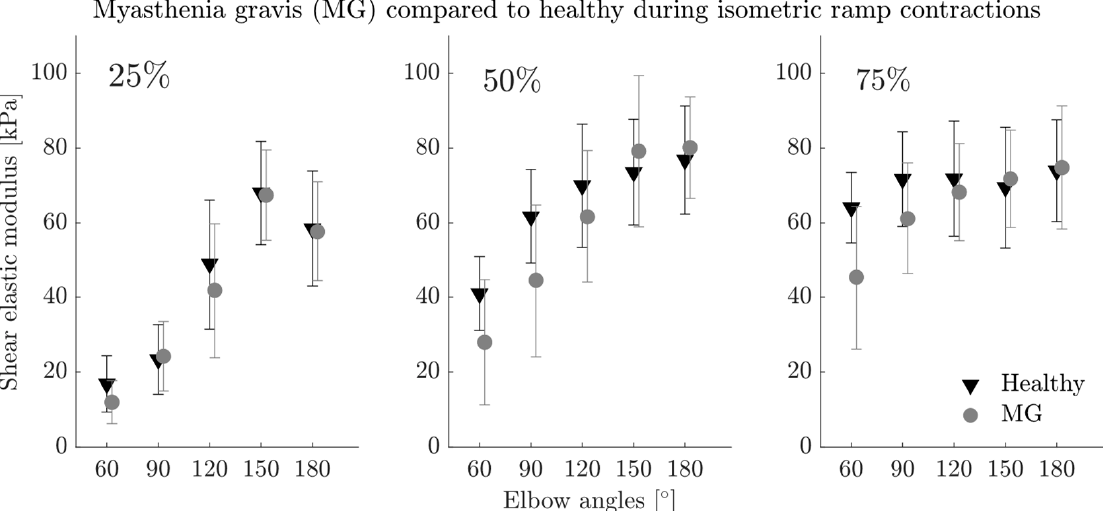
Figure 6. Average total shear elastic modulus of the biceps brachii muscle of myasthenia gravis (MG) patients (grey circles) compared to the healthy group (black triangles) reported previously [13] at 25%, 50% and 75% of maximum voluntary contraction (MVC) torque for the five elbow angles studied (60 ◦ , 90 ◦ , 120 ◦ , 150 ◦ and 180 ◦ ). Error bars visualize the standard deviation. Two-way ANOVA showed significant differences between the groups at 75% MVC ( p =